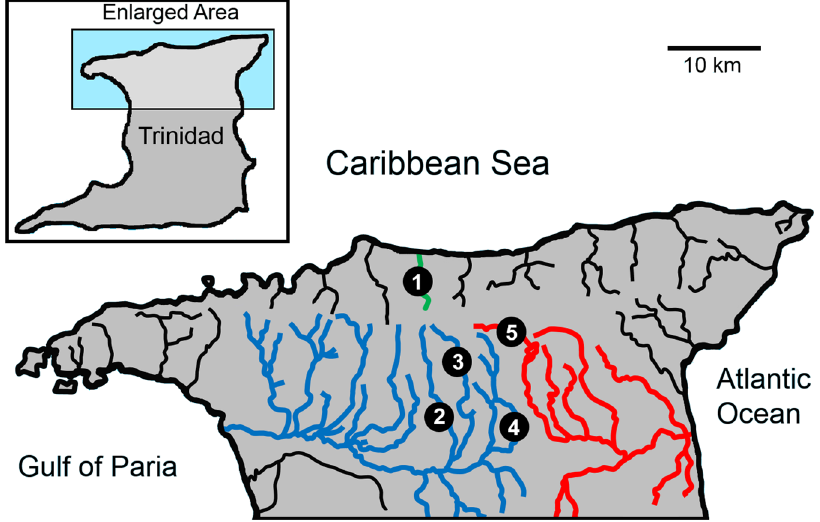
Figure 1. Map showing study rivers. (1) Marianne; (2) Arima; (3) Guanapo; (4) Aripo; (5) Quare. Streams constituting the Caroni drainage are in blue, the Oropuche (Quare only) in red, and the Marianne in green. Modified from El-Sabaawi et al .